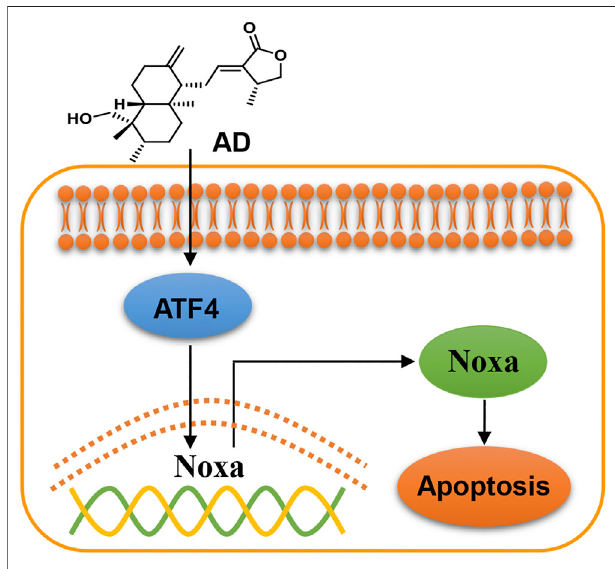
FIGURE 6 | Working model of andrographolide-induced ATF4/Noxa- dependent apoptosis. AD triggered human lung adenocarcinoma cells apoptosis by transcriptionally activating ATF4 and subsequently transactivating the pro-apoptotic BH3-only protein